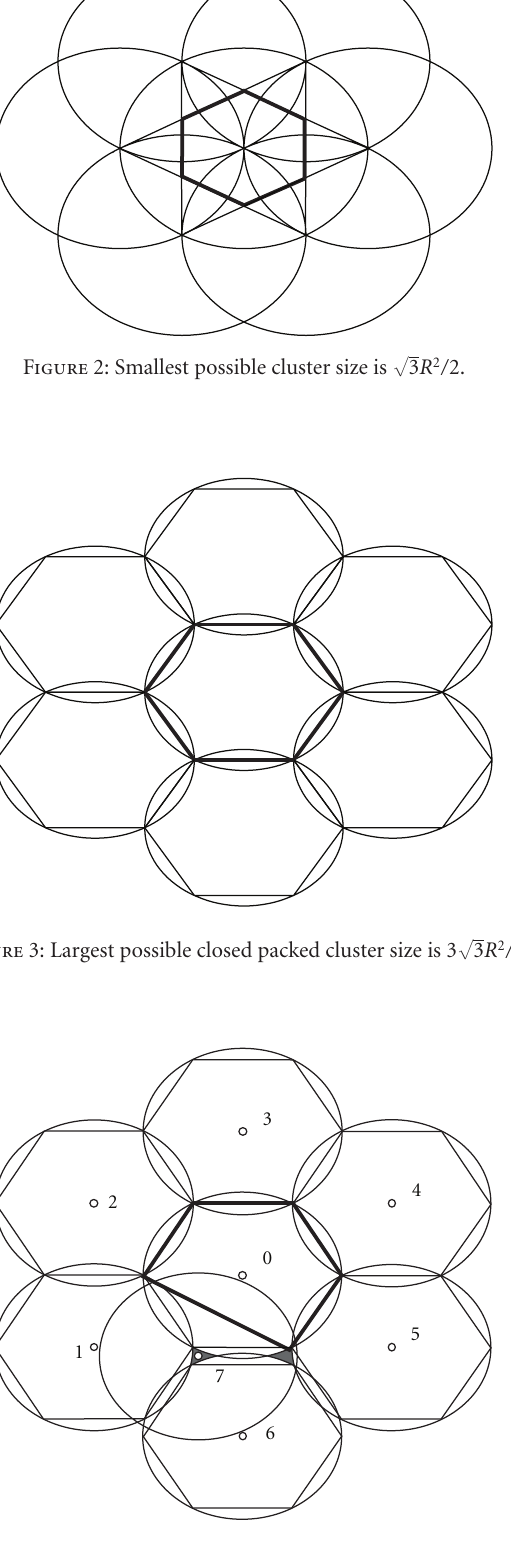
Figure 4: Cluster area more than 3 with area A u (shaded in gray).